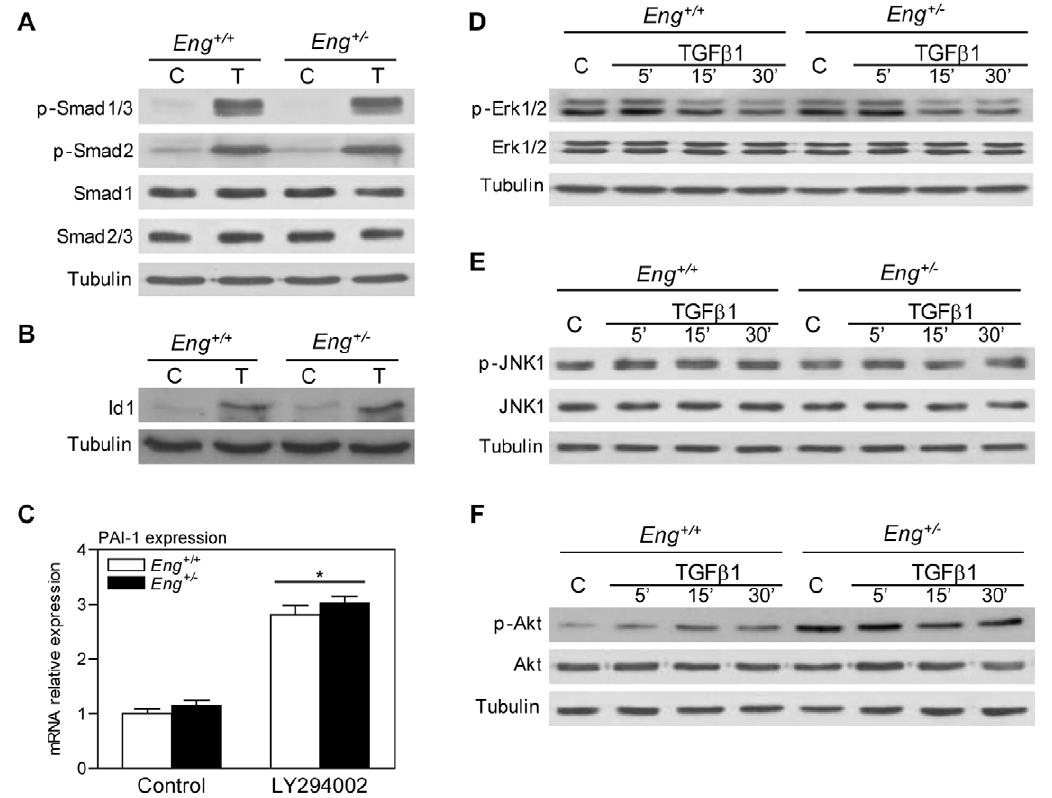
Figure 6. Effect of endoglin haploinsufficiency on TGF b 1 signaling pathways. ( A ) Eng + / + and Eng + / 2 MDF were stimulated with 1 ng/ml TGF b 1 for 30 minutes. Total protein extracts were analyzed by western blot with anti-phospho-Smad1/3, anti-phospho-Smad2, anti-Smad1 and anti- Smad2/3 ( B ). Id1 expression was assessed by western blot after 1 hour TGF b 1 treatment. ( C ) TGF b 1-induced PAI-1 expression increment was analyzed by quantitative RT-PCR. A representative experiment of three independent experiments using triplicate samples is shown. ( D – F ) MAPKs and PI3K/Akt pathways were analyzed after stimulation with 1 ng/ml TGF b 1 for 5, 15 and 30 minutes. Total proteins extracts were resolved by western blot and incubated with anti-phospho-Erk1/2 and anti-Erk1/2 ( D ), anti-phospho-JNK1 and anti-JNK1 ( E ) and anti-phospho-Akt and anti-Akt ( F ) respectively. Tubulin was used as loading control. Mean + SEM is represented (n=3). * p , 0.05-significance of the difference between TGF b 1 treatment and control conditions, Two-way ANOVA. A representative blot from three independent experiments is